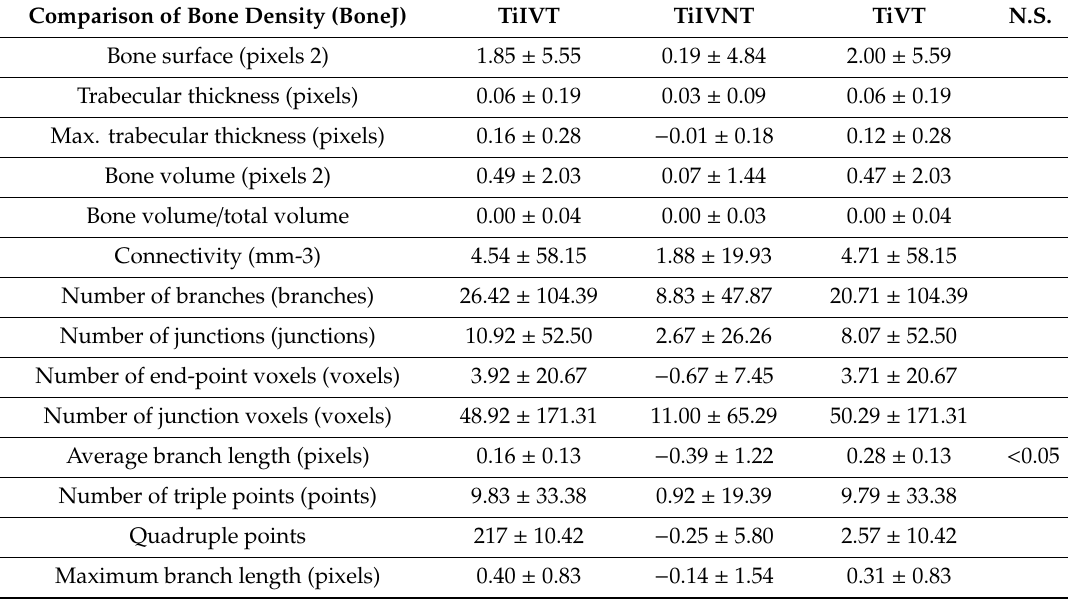
Table 3. Comparison of Bone Density (BoneJ).